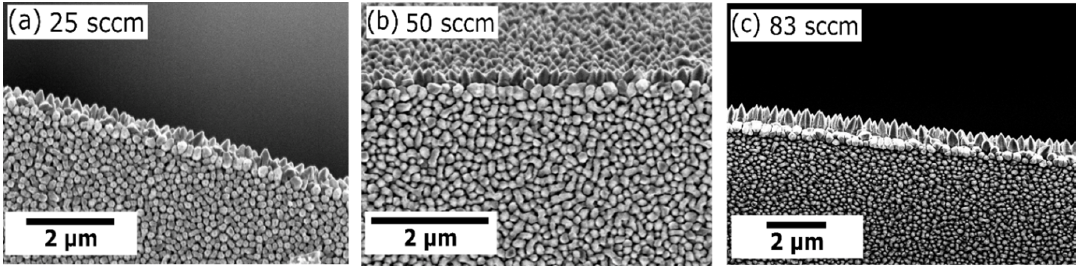
Figure 4. SEM images showing the morphology of ZnO nanowhiskers grown at different oxygen flows ( a ) 25 sccm, ( b ) 50 sccm, and ( c ) 83 sccm. Nanowhiskers facets and tips become more pronounced with increasing flow.